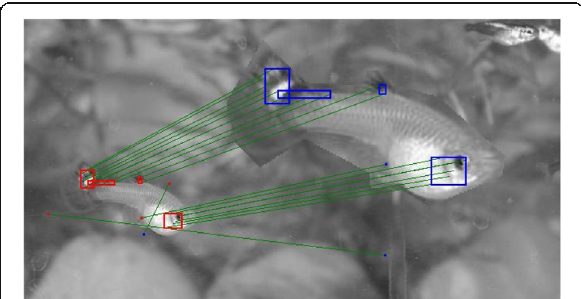
Fig. 3 Clustering result based on [16]. The matching pairs belonging to the same group are segmented into different groups, such as red subgroups or blue subgroups